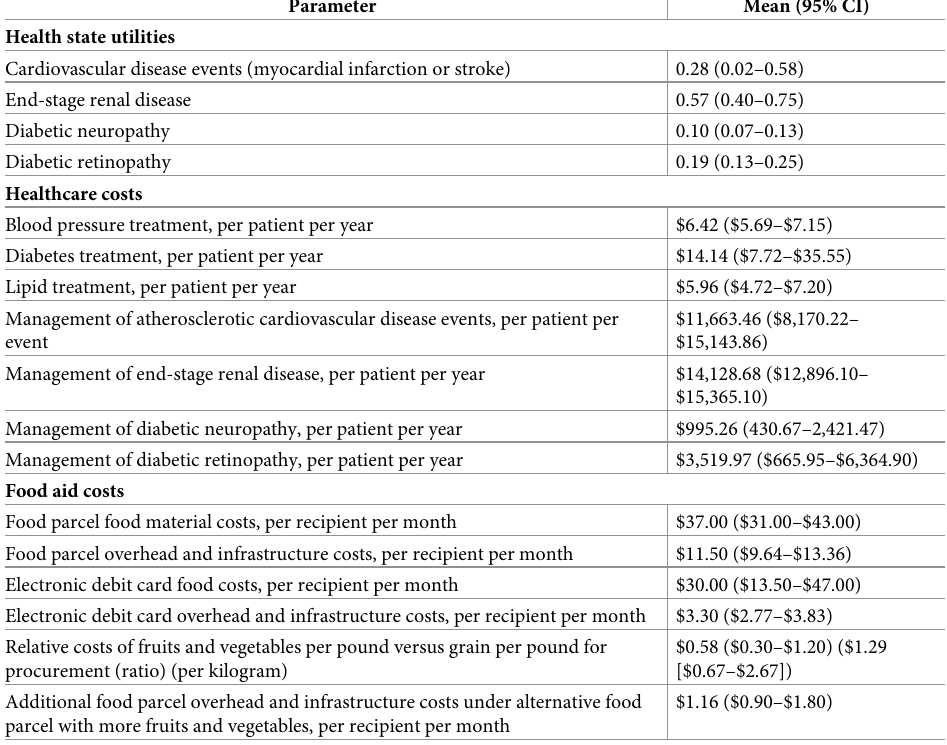
Table 2. Input parameters for estimating the cost-effectiveness of shifting from traditional food parcel delivery (“in-kind” food aid) to electronic debit card delivery of food aid (“e-vouchers”). Costs are in 2017 US dollars and reflect negotiated prices for UN Relief and Work Agency facilities, including out-of-pocket costs to patients and costs absorbed by UN facilities. See S2 Table for impact inventory. Health utilities refer to the degree of disability on a scale from 0 to 1 conferred by a given disease (with larger disutilities indicating more disabling disease, and 1 indicating death). Parameter Mean (95%